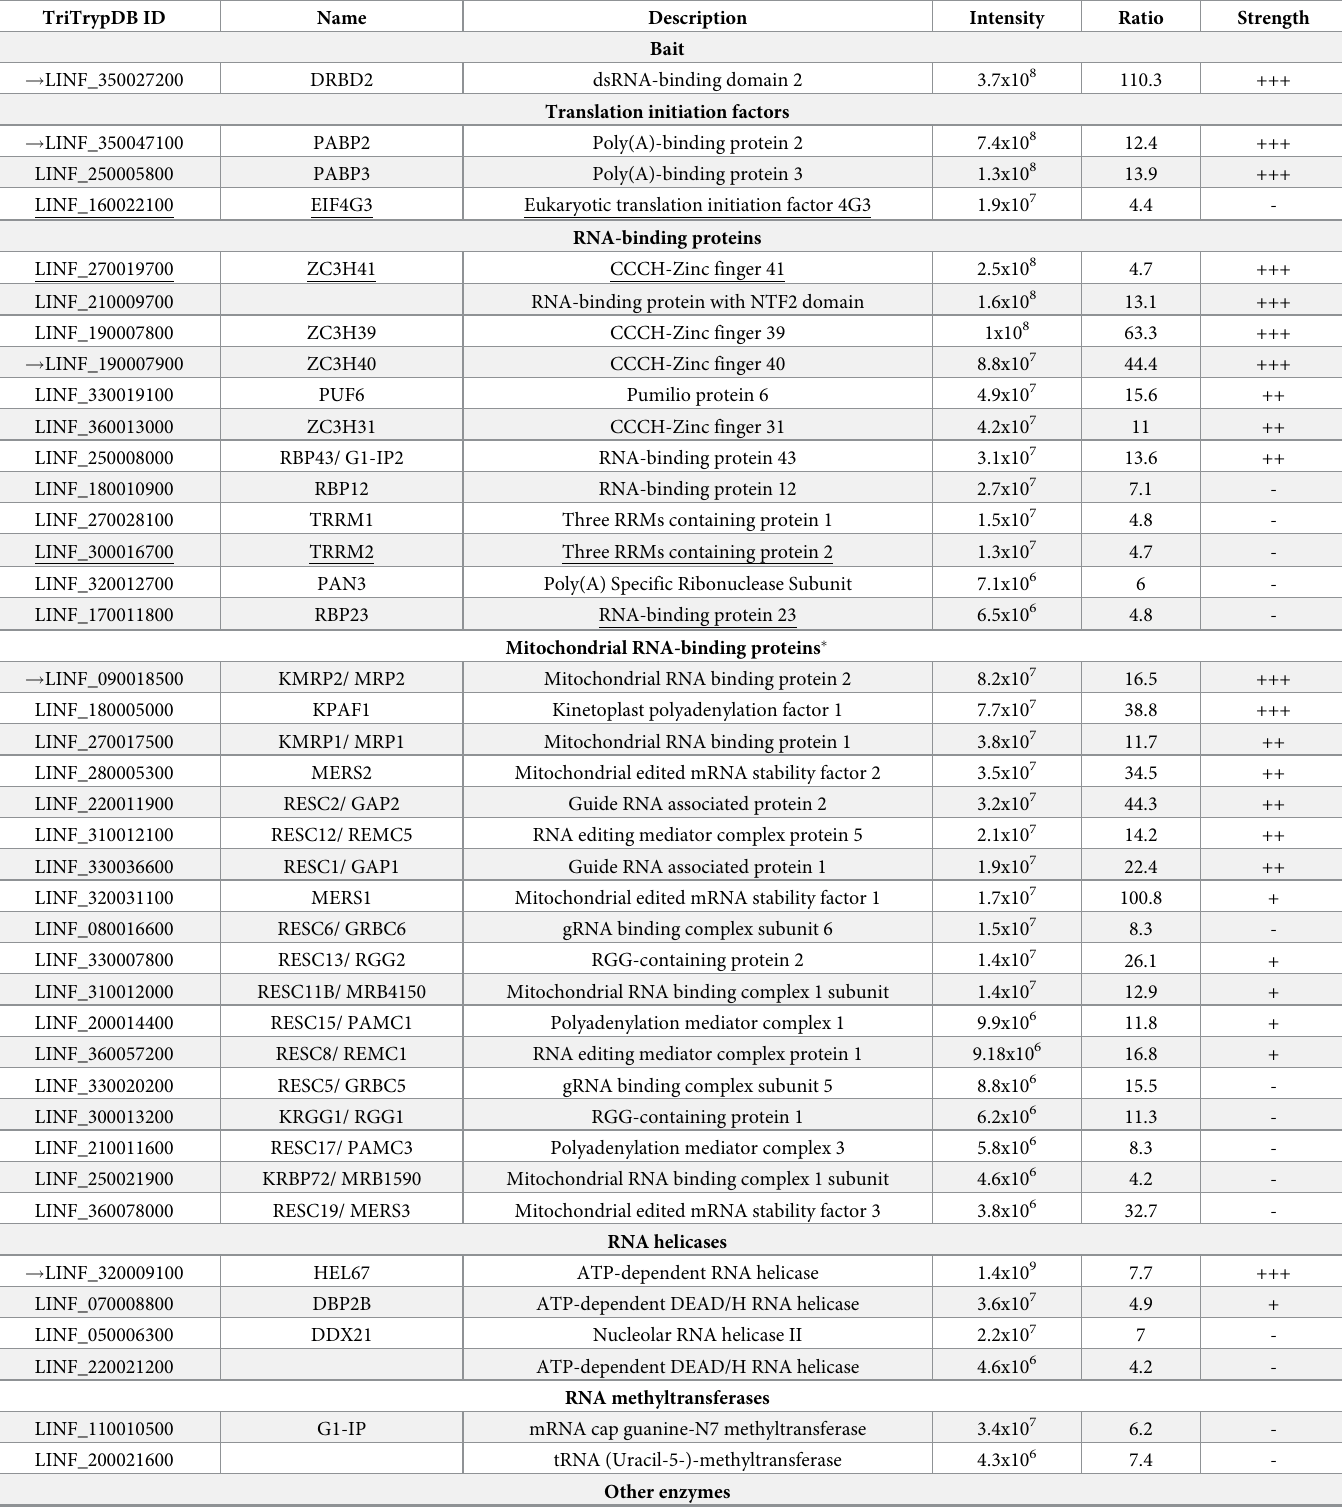
Table 2. Proteins specifically co-immunoprecipitating with L . infantum DRBD2. TriTrypDB